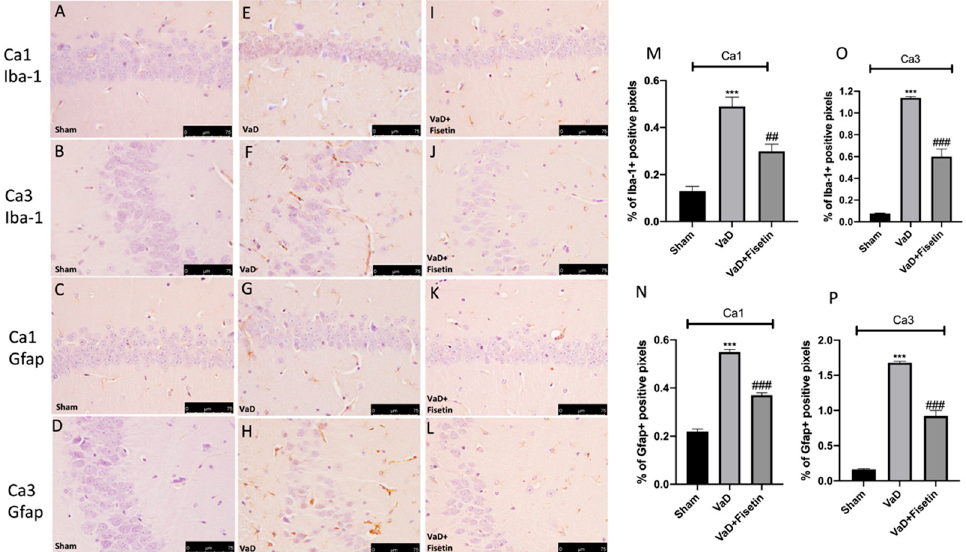
Figure 4. Fisetin administration on astrocyte and microglial activation. Immunohistochemistry for GFAP and IBA-1 in CA1 and CA3 regions, respectively, ( A – D ) sham group, ( E – H ) VaD + vehicle group, ( I – L ) VaD + Fisetin group. The results are expressed as % of positive pixels ( M – P ). Figures are representative of at least three independent experiments. Values are means ± SEM of 6 animals for each group. *** p < 0.001 vs. sham, ### p < 0.001 vs. VaD, ## p < 0.01 vs. VaD. Scale bar: 75 μ m. Magnification (40X).